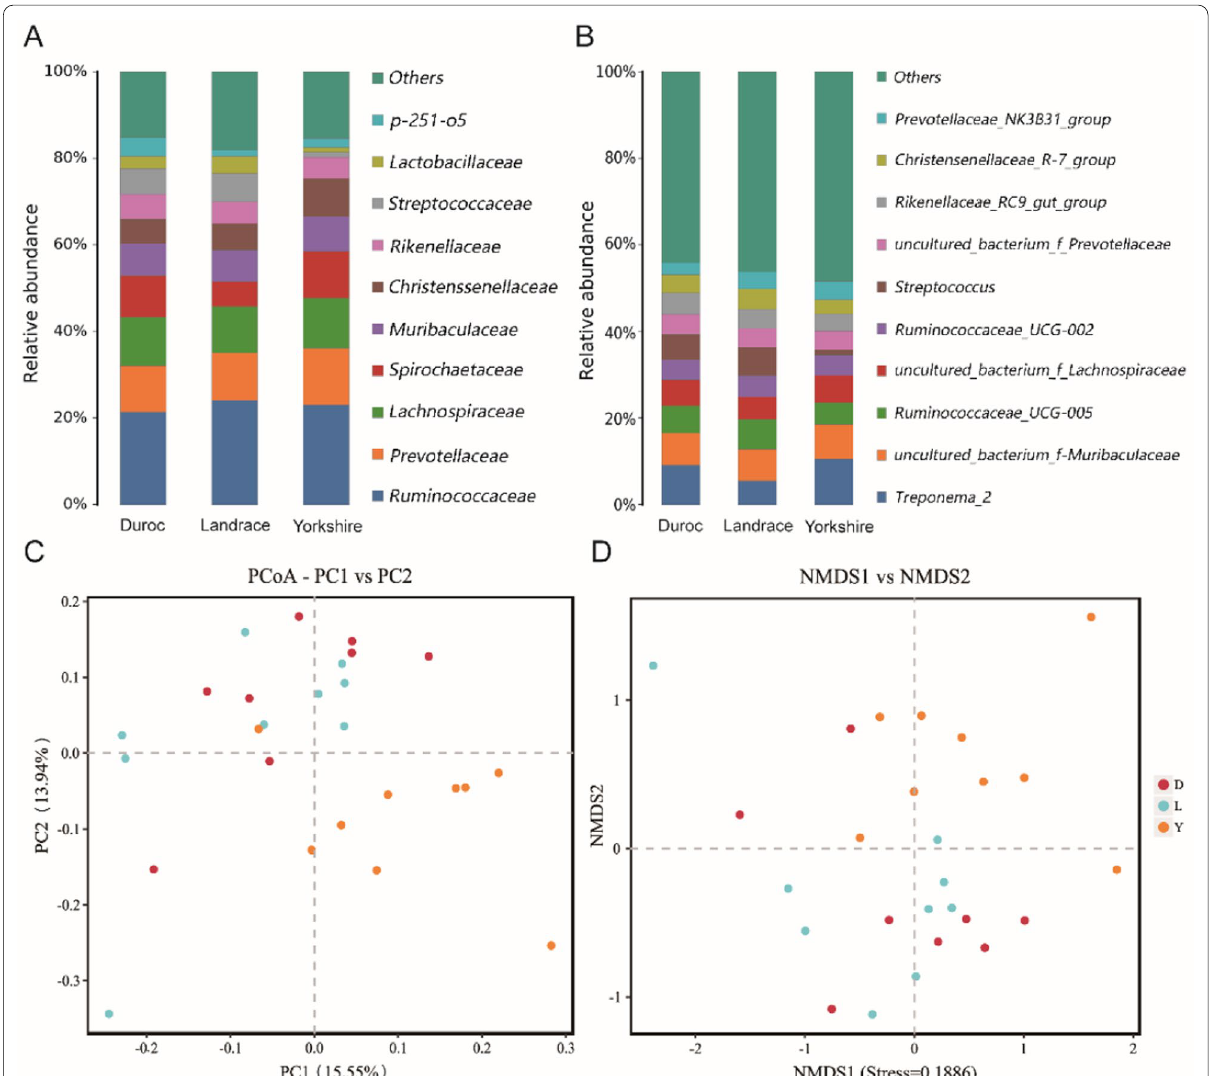
Fig. 1 A Histogram of species abundance at the family level of gut microbiota ofdifferent breeds; B Histogram of species abundance at the genus level of gutmicrobiota of different breeds; C PCoA of three breed samples; D NonmetricMultidimensional Scaling (NMDS) of bacterial communities of three breeds ofpigs (Duroc, Landrace and Yorkshire) based on Bray-Curtis